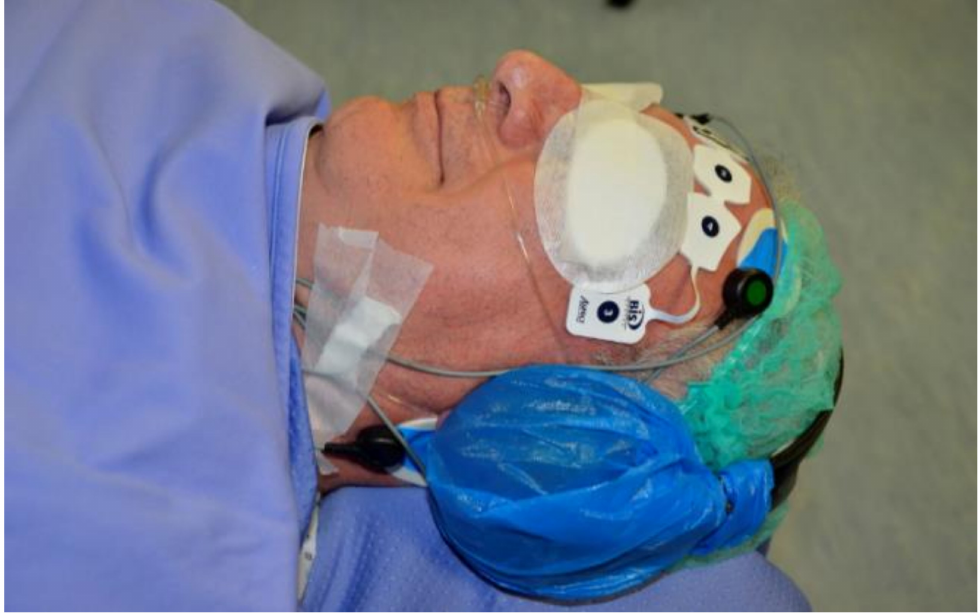
Figure 1. Patient equipped with headphones for the middle latency auditory evoked potential index (MLAEPi) and sensors for the bispectral index